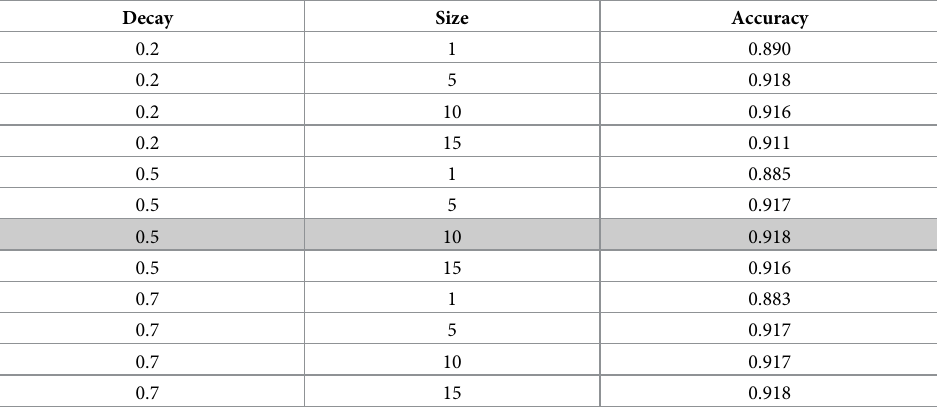
Table 4. Parameter setting for the Neural Network.